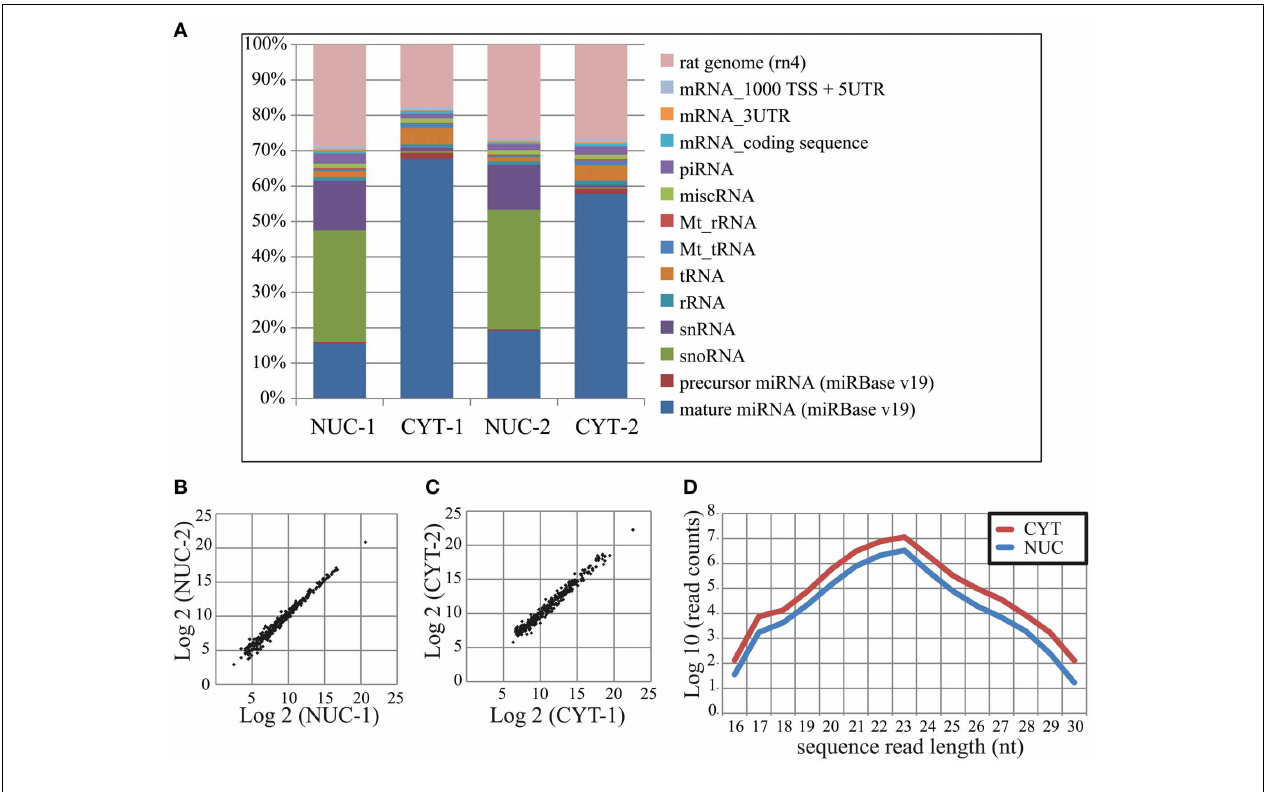
FIGURE 2 | Small RNA deep sequencing after nucleo-cytoplasmic fractionation of neurons. (A) Proportional distribution of mapped sequencing read counts in the small RNA libraries. The total read counts were set to 100% for each small RNA library. (B,C) Scatterplots of log 2